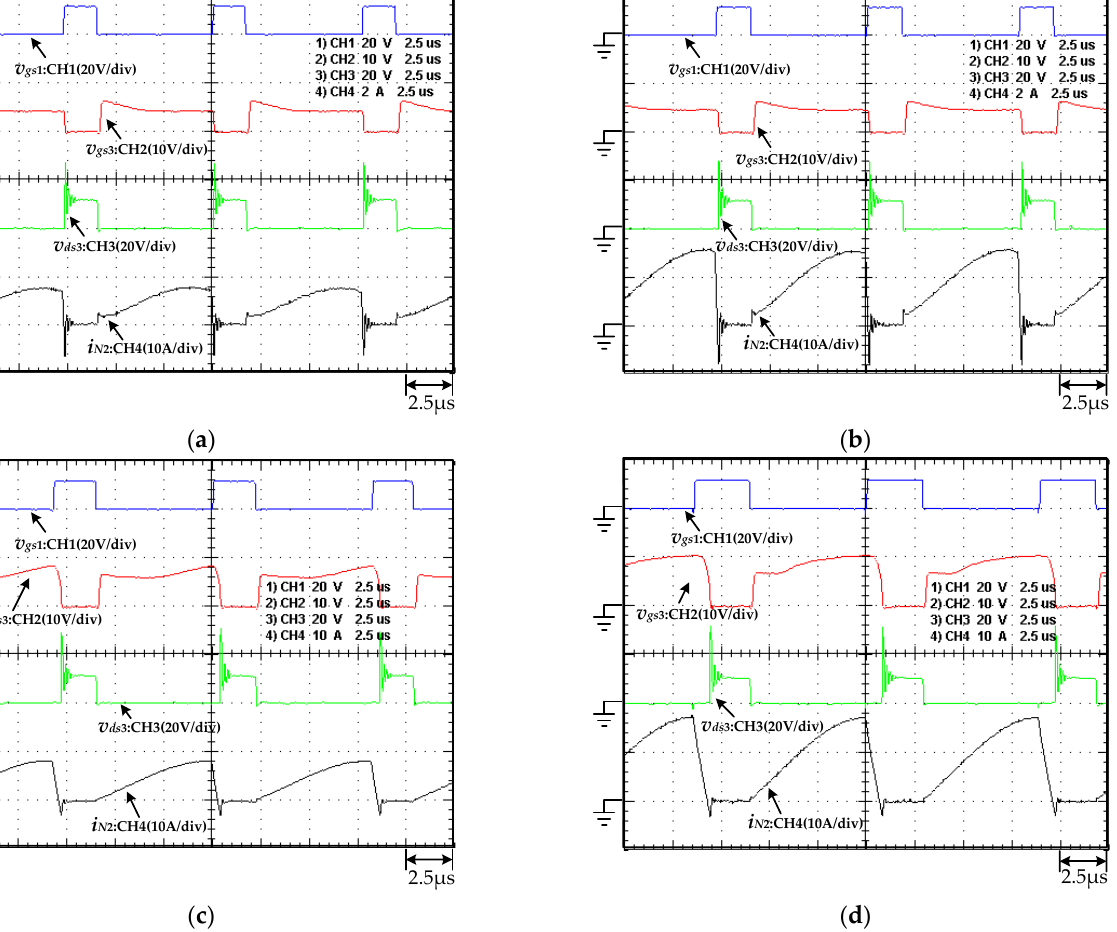
Figure 13. Measured waveforms of v gs 1 , v gs 2 , v ds 3 , and i N 2 at input 24 V under ( a ) 10% load; ( b ) 20% load; ( c ) 50% load; and ( d ) 100% load.